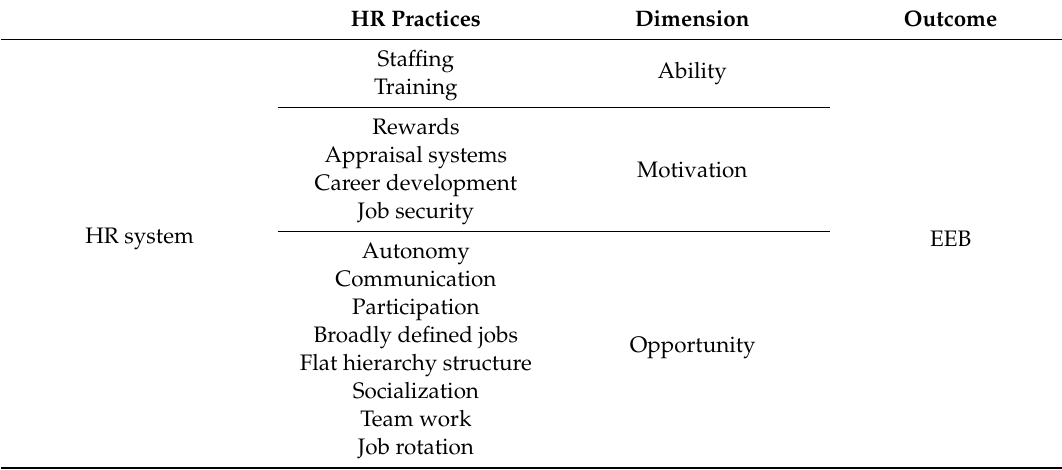
Table 1. Composition of an HR system fostering